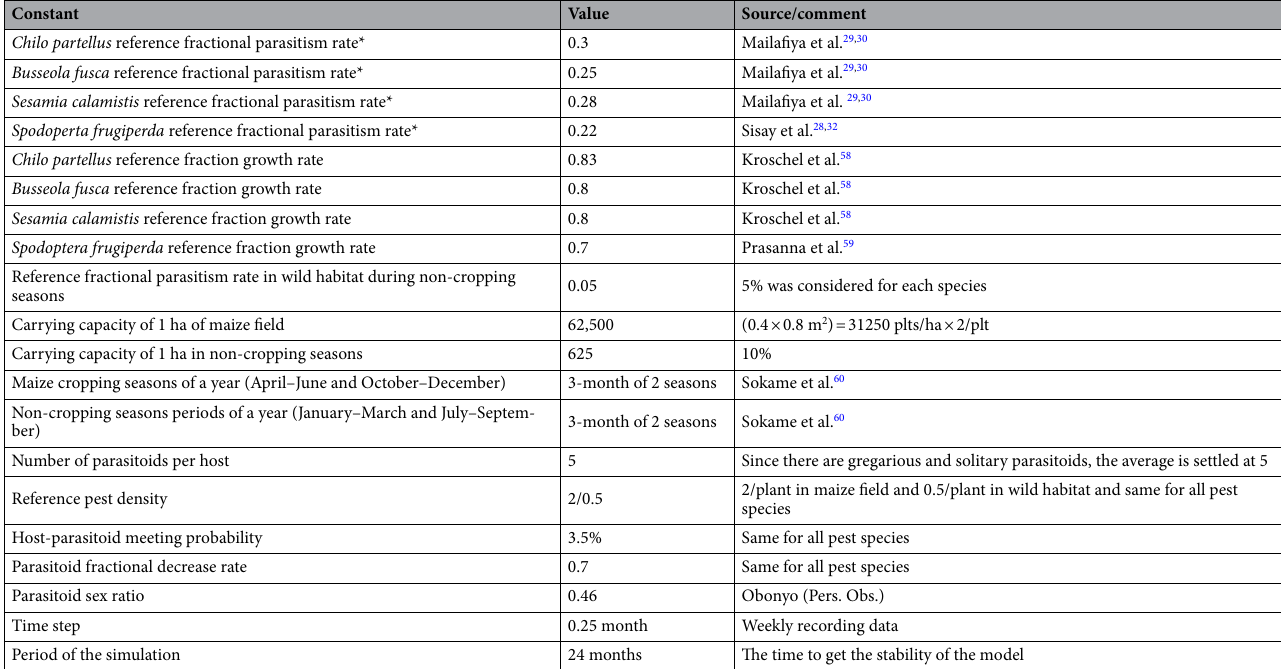
Table 2. Value of constants used in model simulation. * The parasitism level of all parasitoids species on a given host were lumped